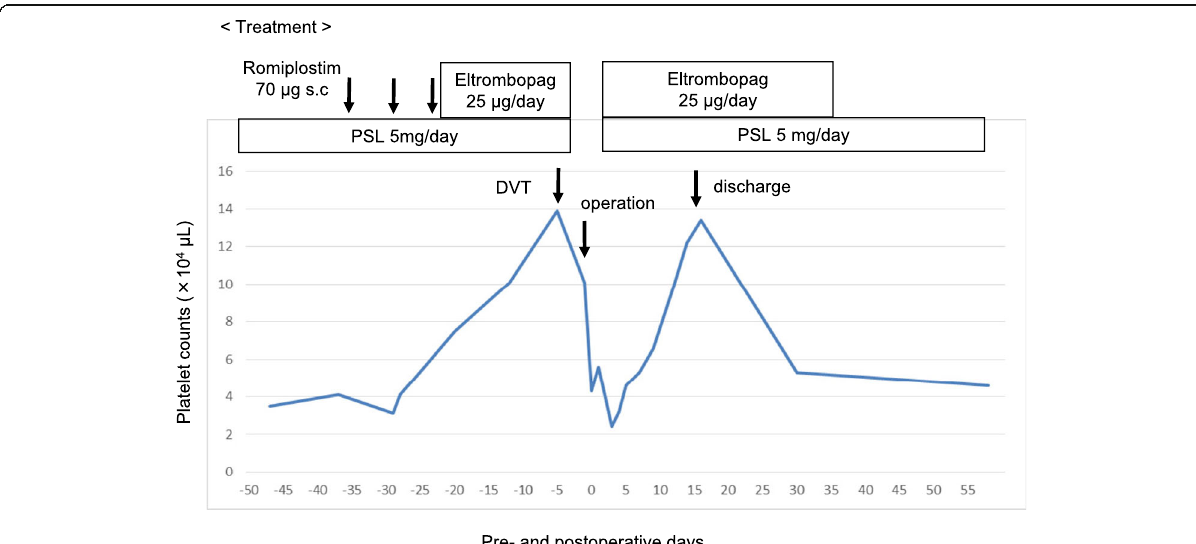
Fig. 2 Clinical course with platelet counts and treatment using thrombopoietin receptor agonist